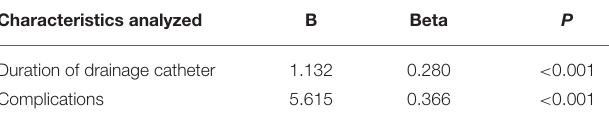
TABLE 7 | Multiple linear regression analyses of characteristics related to length of hospital stay after surgery in 41–79 years old women patients with chronic subdural